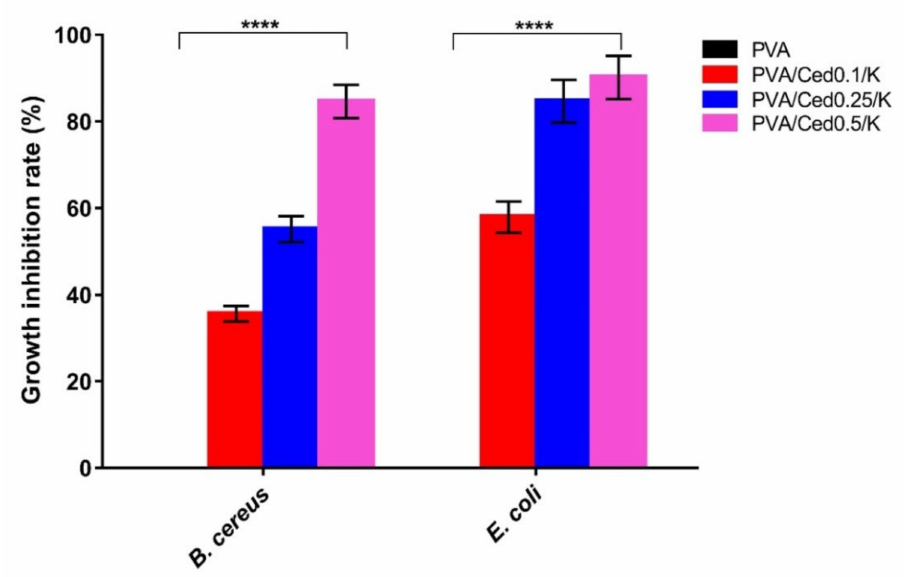
Figure 8. Antibacterial evaluations of PVA/Ced/K composite sponges against B. cereus and E. coli compared to the PVA sponge. Results are presented as mean ± SD (**** p <